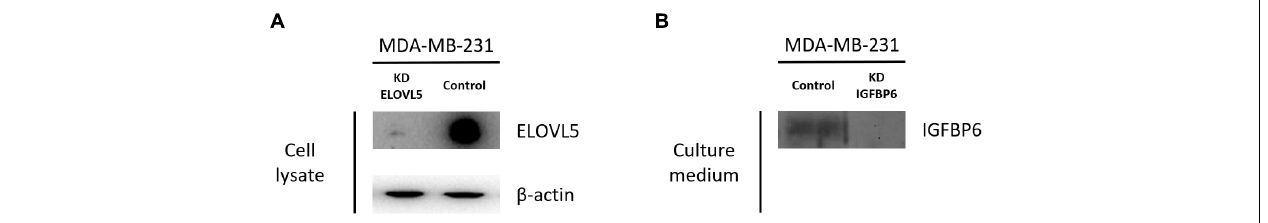
FIGURE 2 | Results of analysis of the expression of ELOVL5 and IGFBP6 proteins by Western blotting. (A) Relative expression of the ELOVL5 protein in the MDA-MB-231 (ELOVL5) cell line compared to the control cell line. (B) Relative content of the IGFBP6 protein in the conditioned cell culture medium of MDA-MB-231 (IGFBP6) cell line compared to the control cell line (samples were normalized to the number of cells).